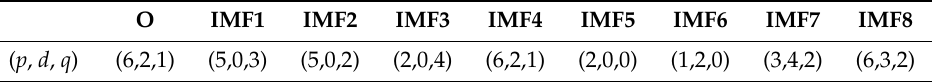
Table 8. ARIMA model structures of original data and EMD components.